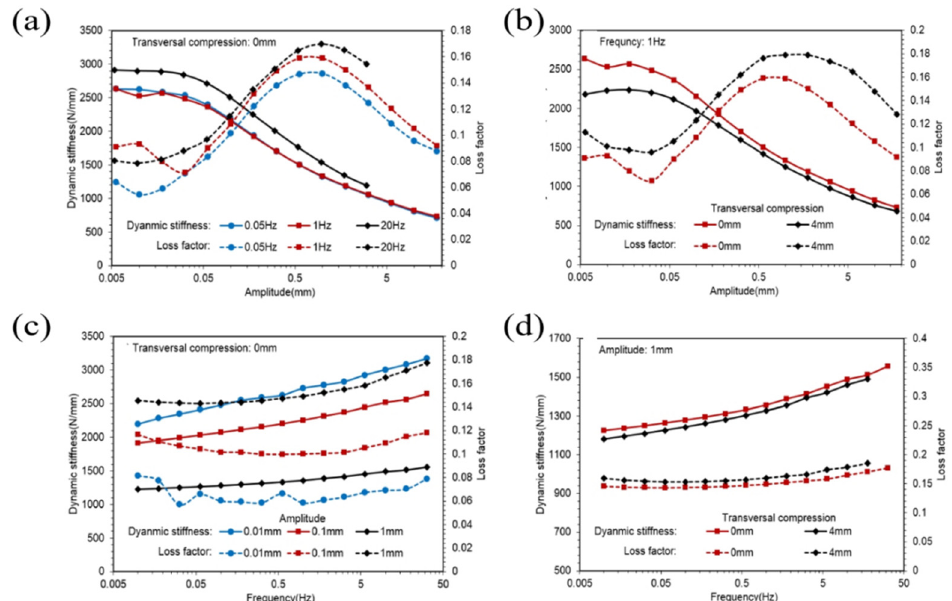
Figure 4. Dynamic stiffness and loss factors curves of the ST rubber spring. ( a ) Dynamic stiffness and loss factors of the ST rubber spring with amplitudes of different frequencies. ( b ) Dynamic stiffness and loss factors of the ST rubber spring against the am-plitude in different transversal compressions. ( c ) Dynamic stiffness and loss factors of the ST rubber spring against the frequency in different amplitudes. ( d ) Dynamic stiffness and loss factors of the ST rubber spring with transversal compression in different amplitudes.